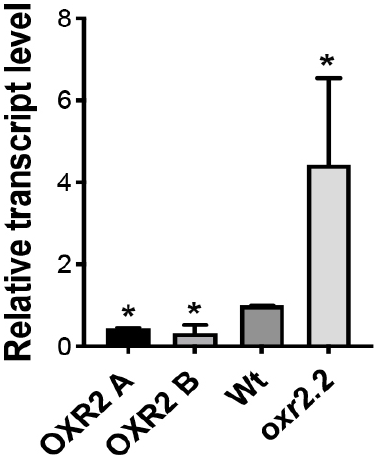
Figure 4. Relative transcript levels of PbActin vs. AtActin determined by qPCR at 20 dai in OXR2-OE lines A and B, WT, and oxr2 plants. Low relative transcript levels denote that a small amount of pathogen is present relative to the host cells. Asterisks indicate significant differences of tree biological replicates of each genotype at p < 0.01 (*) (ANOVA, LSD Fisher test).